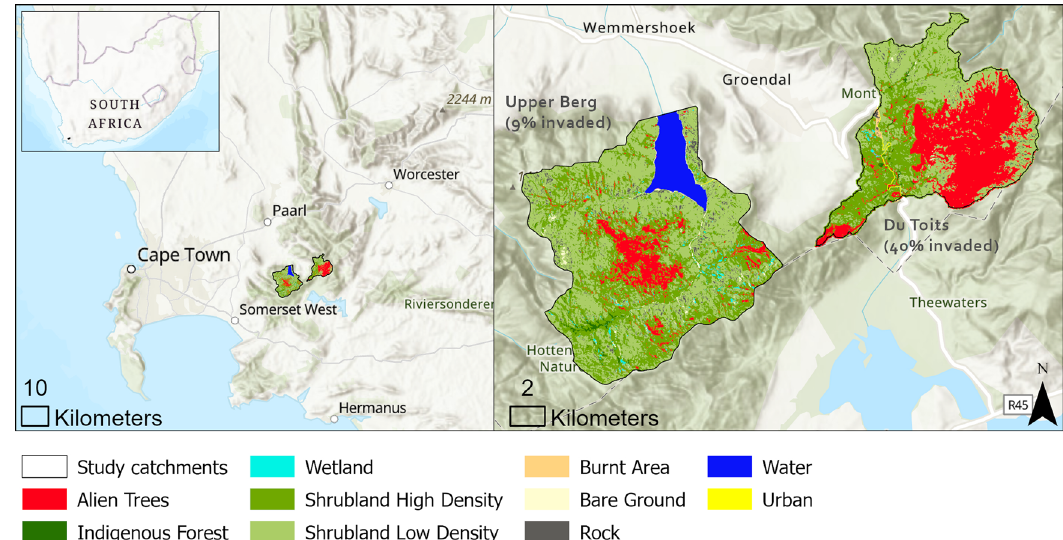
Fig. 2 Study catchments. Mountainous catchments, the Upper Berg and Du Toits, critical for water supply to the City of Cape Town in South Africa, and the level of invasive alien tree (IAT) infestations during the drought period (as described in ref. 67 ). Base map: Esri, NASA, NGA, USGS, Esri South Africa, HERE, Garmin, METI/NASA, FAO, NOAA.